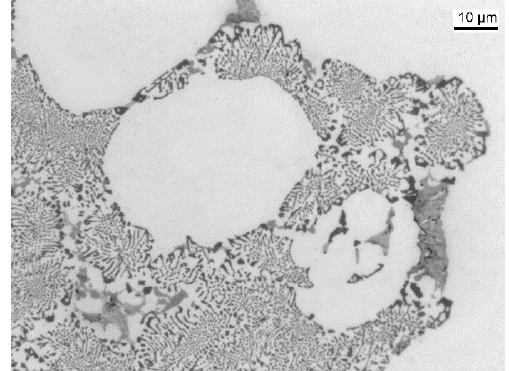
Figure 2. Eutectic Si particles in as-rheocast condition.